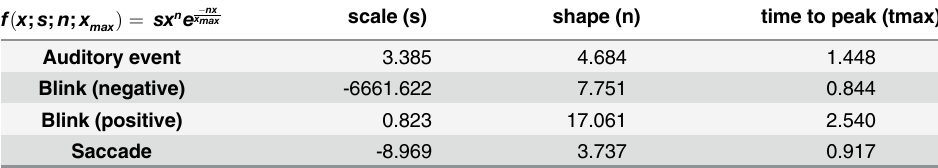
Table 2. Parameters of erlang-gamma distributions for separate response